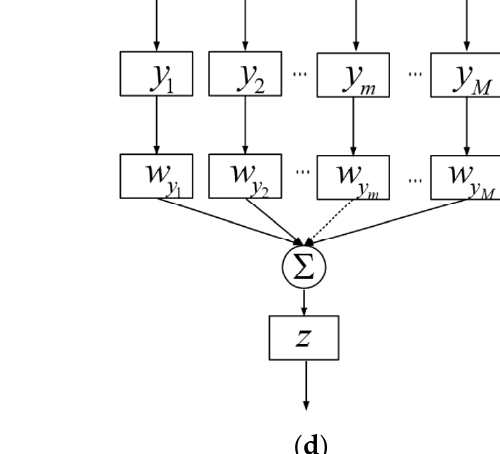
Figure 2. Transceiver channel division model of FDA-Phase-MIMO radar: ( a ) Antenna subarray division model; ( b ) Transmitting subarray model; ( c ) Receiving subarray model; ( d ) Receiving sub-array synthesis model.